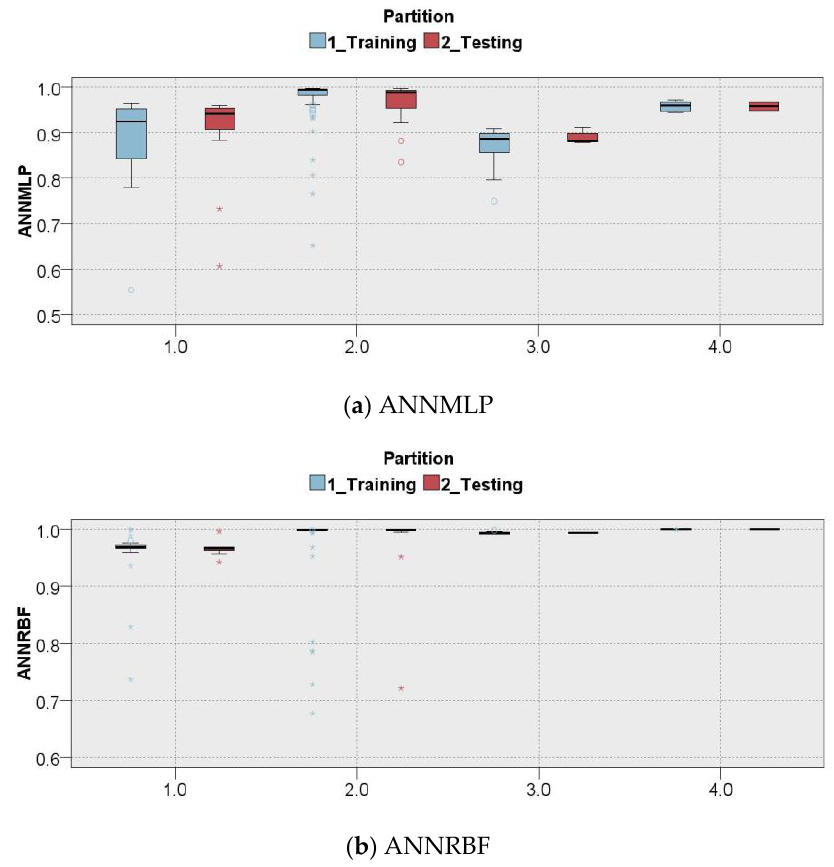
Figure 13. Variability or dispersion of the data in ANNMLP and ANNRBF models.